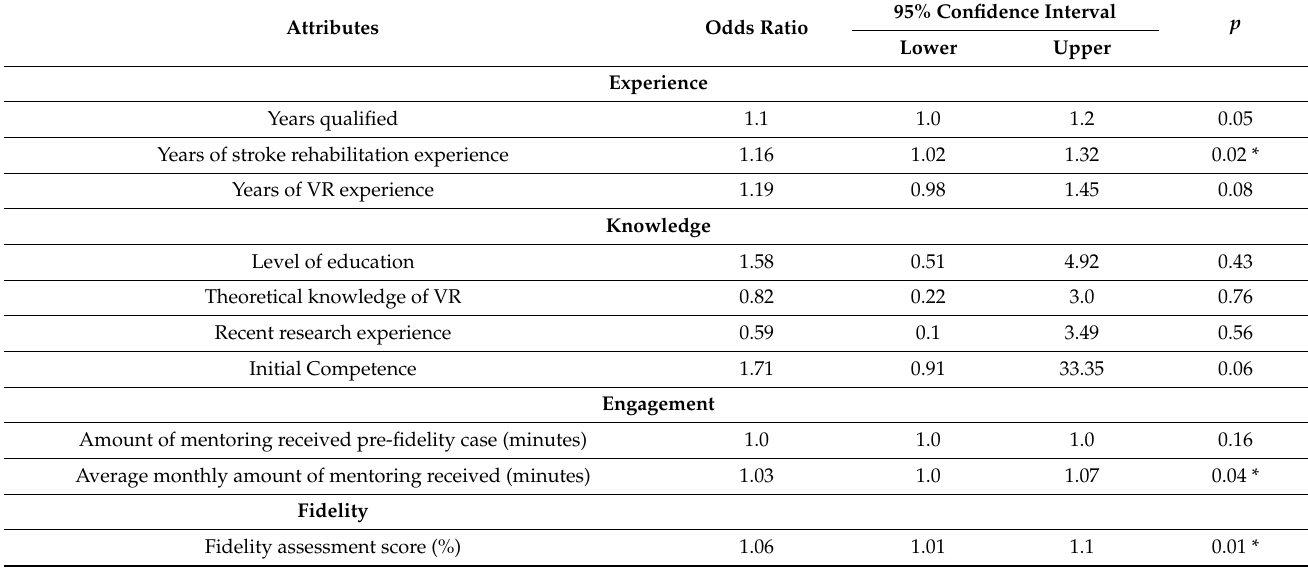
Table 4. Relationship between OT attributes and stroke survivor RTW outcomes at 12 months post-randomisation explored by univariate logistic regression.